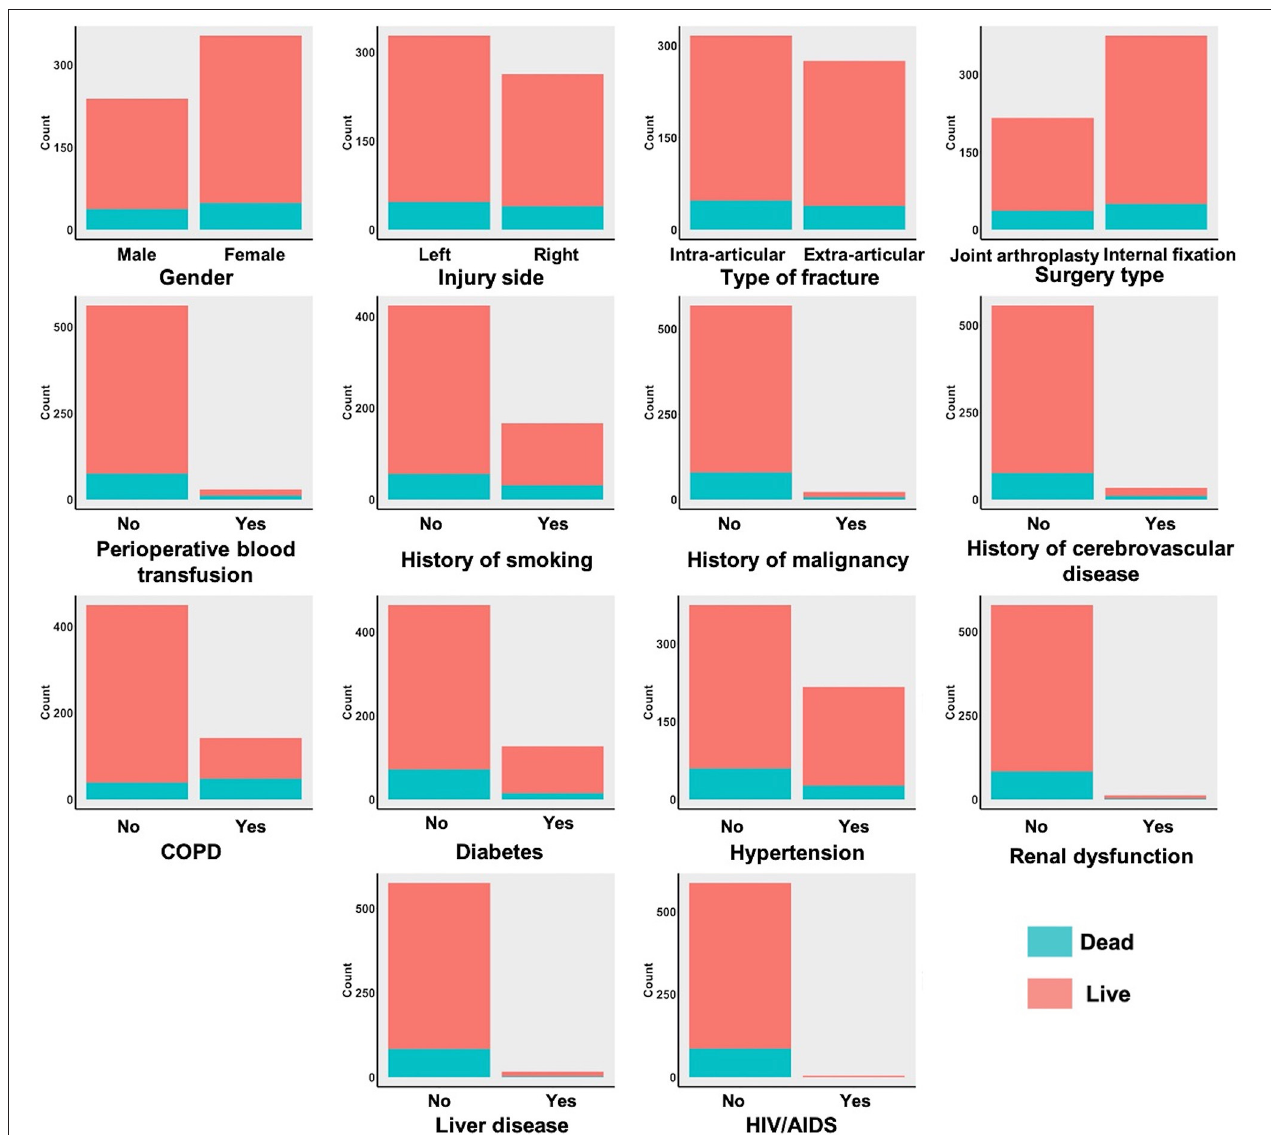
FIGURE 3 | The dichotomous variables of live group and dead